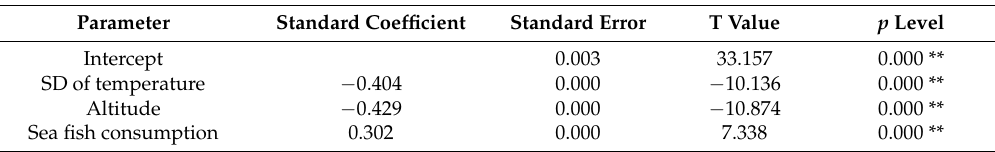
Table 5. Regression coefficient, standard error, t -value and probability of the estimated parameters in longevity model by the stepwise MLR analysis in 2010.